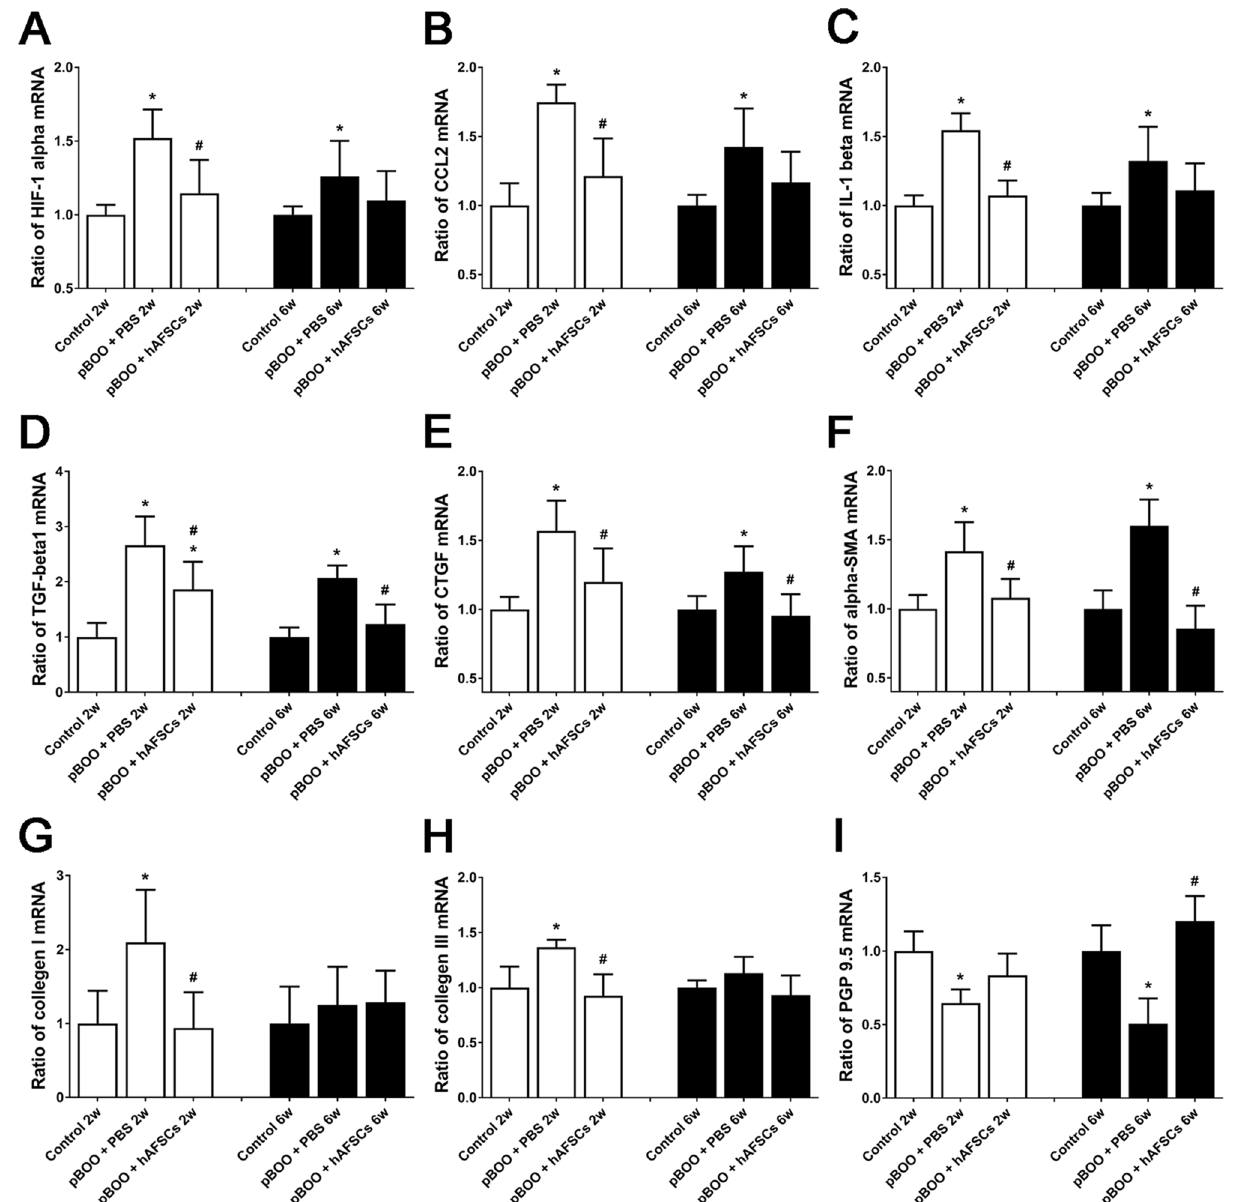
Figure 4. Relative mRNA expressions of hypoxia inducible factor-1α (HIF1α, A ), CCL2 ( B ), interleukin-1β (IL-1β, C ), transforming growth factor-β1 (TGF-β1, D ), connective tissue growth factor (CTGF, E ), α-smooth muscle actin (α-SMA, F ), collagen I ( G ), collagen III ( H ) and protein gene product 9.5 (PGP9.5, I) in the bladder of control, pBOO + PBS and pBOO + hAFSCs treatment. After hAFSCs treatment, the mRNA expressions of CTGF and α-SMA are improved at 2 and 6 weeks after pBOO, but HIF1α, CCL2, IL-1β, TGF-β1, collagen I and collagen III are improved only at 2 weeks after pBOO. The mRNA levels of PGP9.5 are improved after hAFSCs treatment only at 6 weeks after pBOO. *: P < 0.05 vs. control, #: P < 0.05 vs. pBOO + PBS. N = 6 in each time